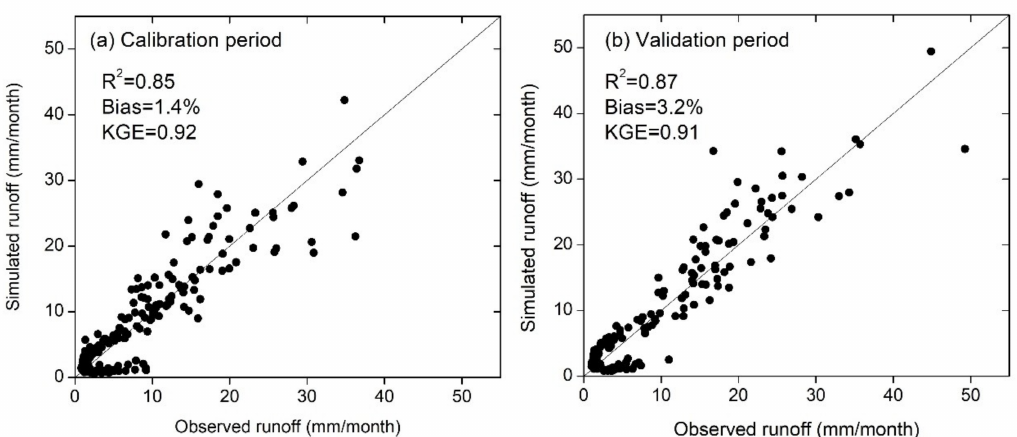
Figure 7. Comparison of the observed and simulated runo ff during the calibration period (1982–1997) ( a ) and the validation period (1998–2014) ( b ).